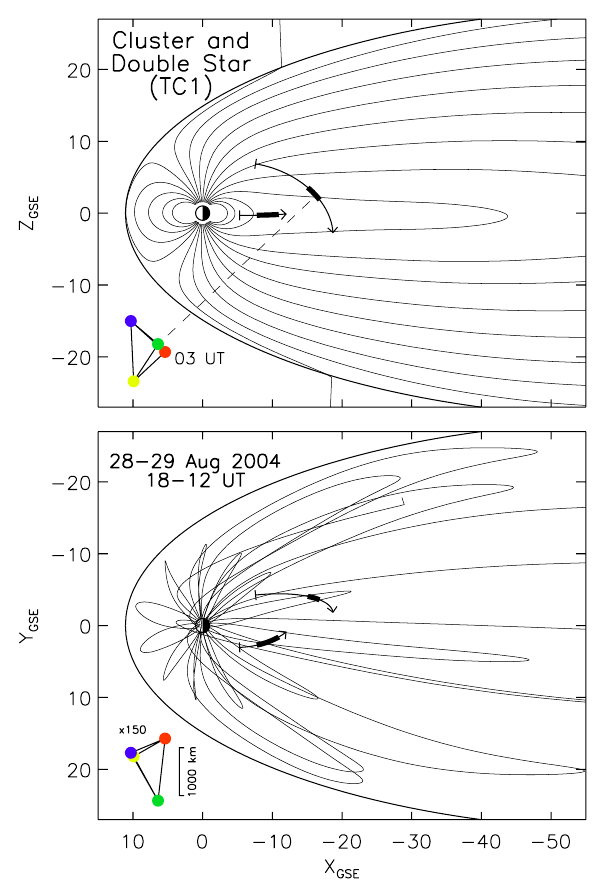
Fig. 1. GSE X-Z and X-Y cuts through the magnetosphere, show- ing field line traces through the T96 magnetic model. Shown also are the Cluster and Double Star trajectories for the intervals 18:00–12:00 UT, 28–29 August 2004, in the case of Cluster, and 00:00–06:00 UT, 29 August 2004, in the case of Double Star. In both cases, the highlighted portion of the trajectory indicates the in- terval 01:30 to 05:00 UT on 29 August, the period bracketing the substorm under consideration. In the bottom-left of each panel is the tetrahedral configuration of Cluster at 03:00 UT, blown up by a factor of